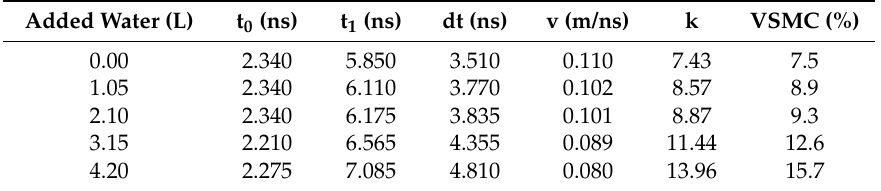
Figure 6. Grumusol soil GPR calibration static measurement in air-dried condition and in the presence of up to 4.2 L of distilled water added to the soil box. ( a ) Air-dried condition; ( b ) 1.05 L added water; ( c ) 2.1 L added water; ( d ) 3.15 L added water; ( e ) 4.2 L added water. The vertical axes are the GPR measurement times. The sections have different amplitude values, which decrease slightly with each step. Table 3. Grumusol soil calibration: static calculations of the GPR-derived VSMC parameters. Added Water (L)